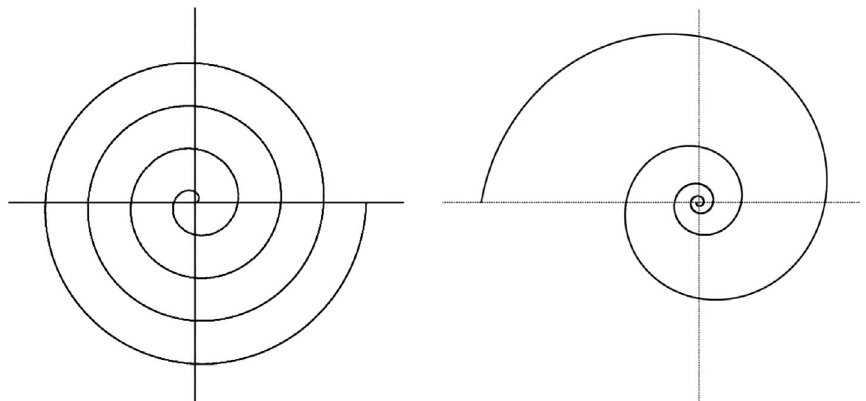
Figure 1. Archimedes vs. Bernoulli